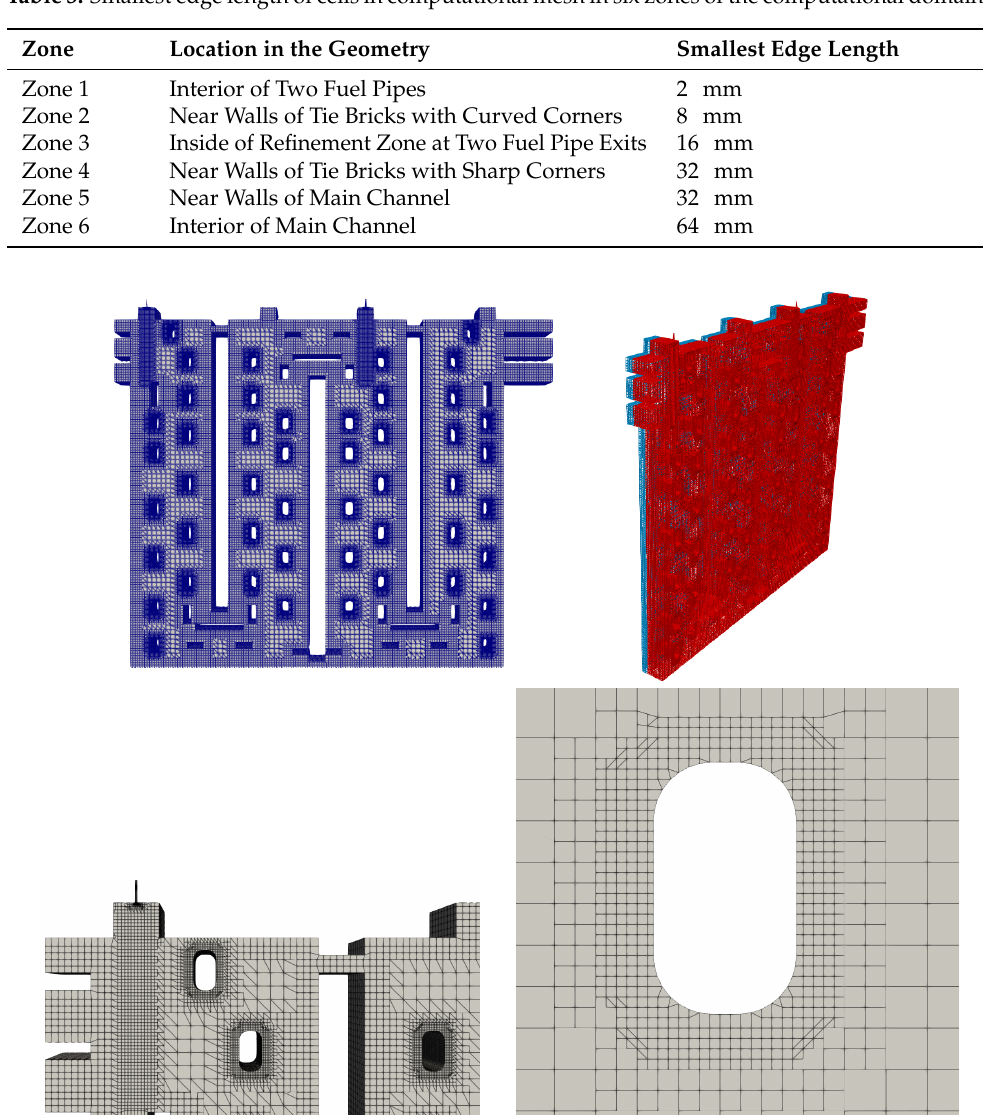
Table 3. Smallest edge length of cells in computational mesh in six zones of the computational domain.